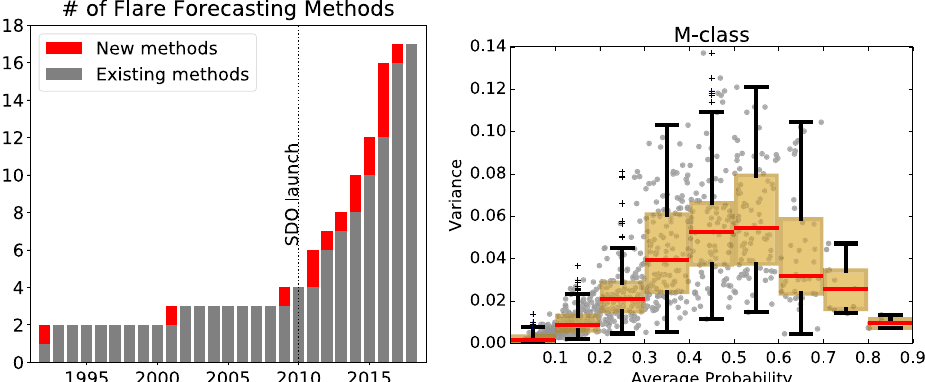
Fig. 1. Left: Number of fl are forecasting methods publicly available per year since 1992. For each year, existing methods (grey) and new methods (red) are displayed. Since 2010 the number of fl are forecasting methods has increased at an average of approximately three every two years. This information was partially gathered from Leka et al. (2019), the NASA/GSFC Community Coordinated Modeling Center (CCMC) archive of forecasts, and other operational centre online archives. The earliest date when the fi rst forecast was made available in these sources was used for the purposes of this fi gure. Right: forecast variance versus average forecast for a six-method group of probabilistic forecasts for M-class fl ares between 2015 and 2017. Variance is lower when the average forecast is closer to zero or